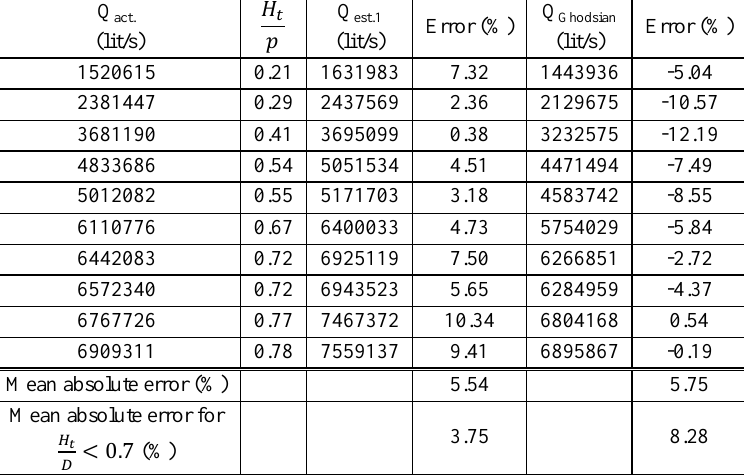
Table 3. Comparison between the flow of Bartletts Ferry dame in the US in various 𝑯 𝒕 calculated flow through the equation proposed by the author and Godsian